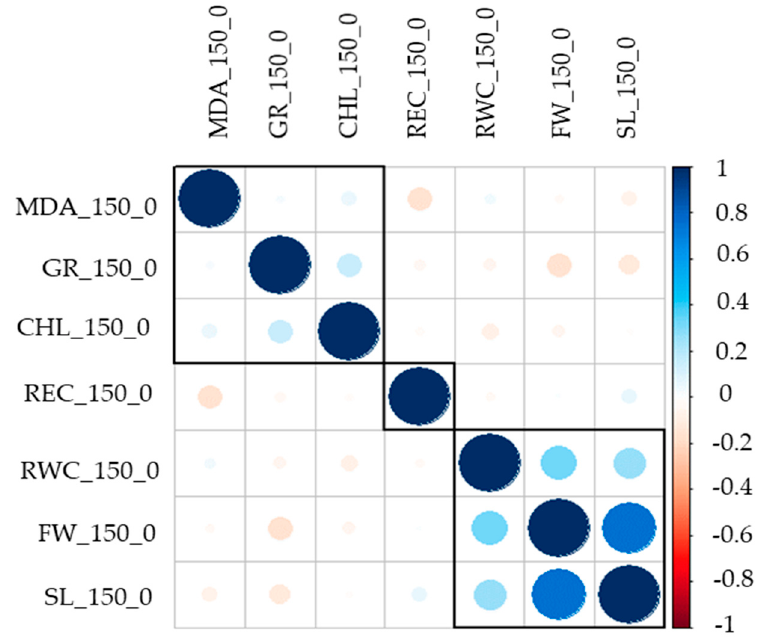
Figure 2. Correllogram shows the correlation among all phenotypic traits color scale shows the strength of the